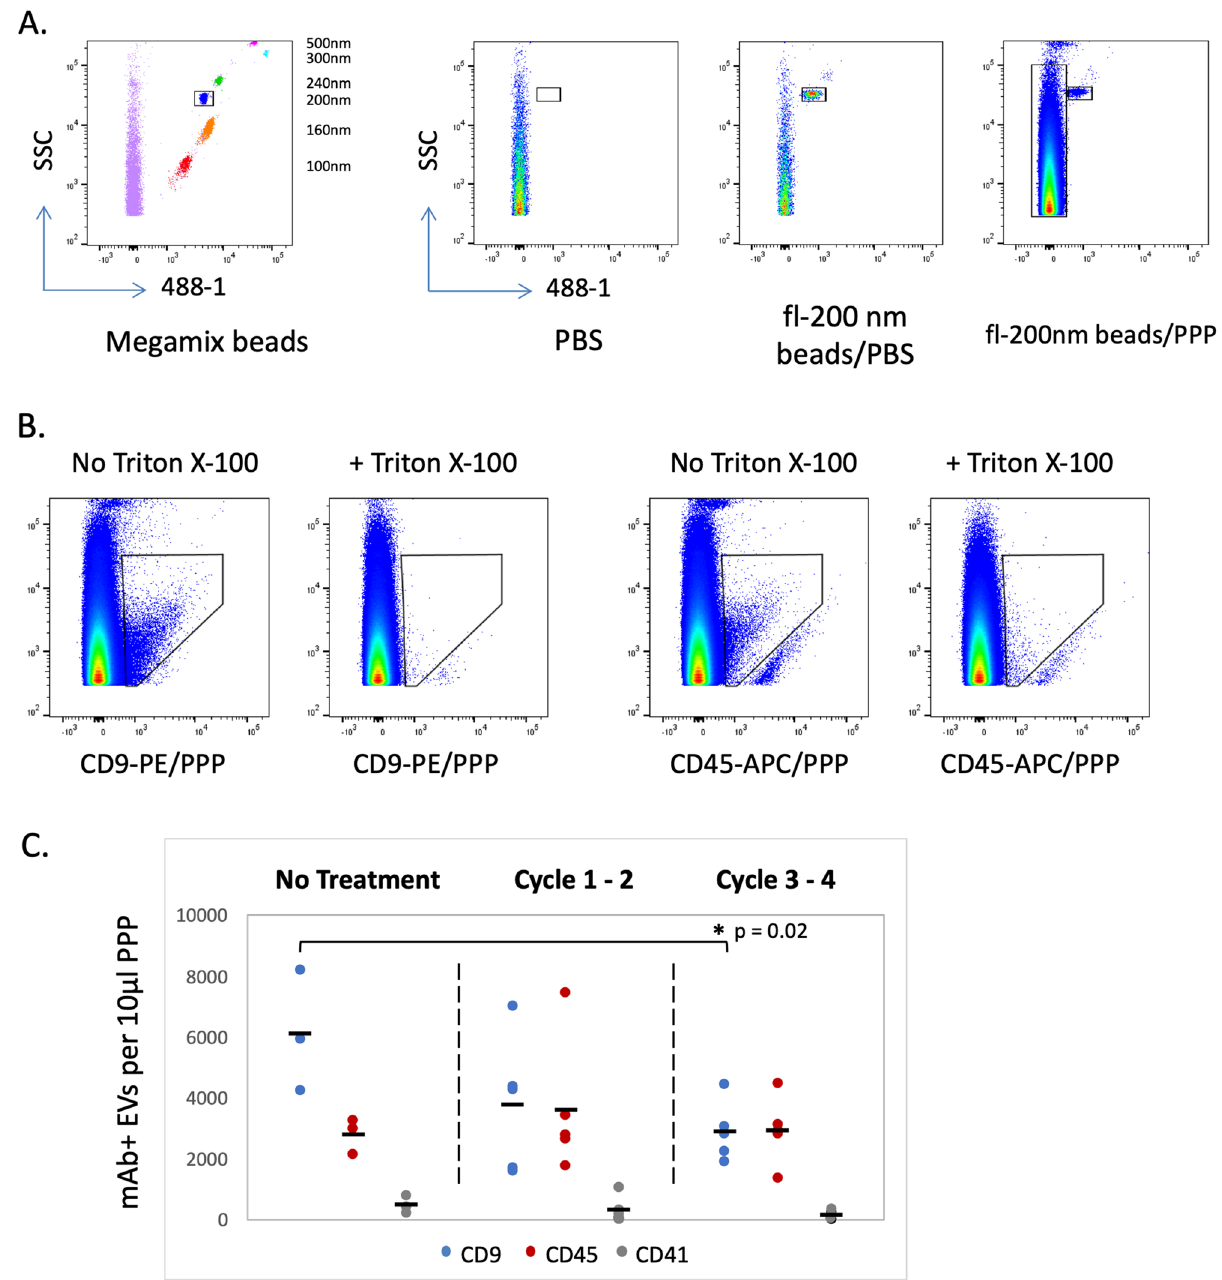
Figure 1. Flow cytometry detection of EVs in PDAC patient plasma. ( A ) Megamix beads (left panel, 100– 500 nm in size) were detected with 488 nm fluorescence and were used to standardize the flow cytometer for acquisition of labeled EVs. Additional panels compare acquisition of PBS alone or PBS with 200 nm Fluoresbrite beads (fl-200 nm) or platelet-poor plasma (PPP) with fl-200 nm beads. ( B ) Detection of CD9 and CD45 antibody staining of plasma EVs is reduced to background by the addition of 0.1% Triton X-100. ( C ) CD9, CD45 or CD41 positive EVs were assessed in PPP samples from PDAC patients receiving neoadjuvant treatment for 0 to 4